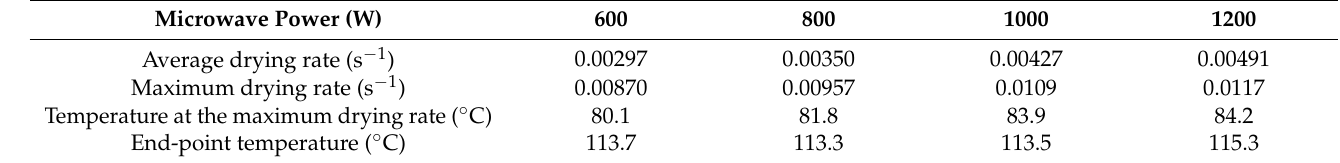
Figure 8. Effects of microwave power on the ( a ) moisture ratio and ( b ) drying rate of CRES in the microwave drying process. Table 4. Variations of microwave drying characteristics of CRES with microwave